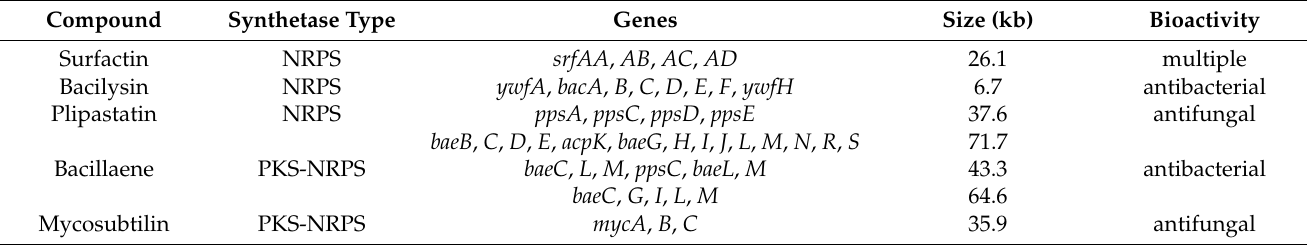
Table 1. Secondary metabolite clusters identified in the genome of Bacillus velezensis TSA32-1.